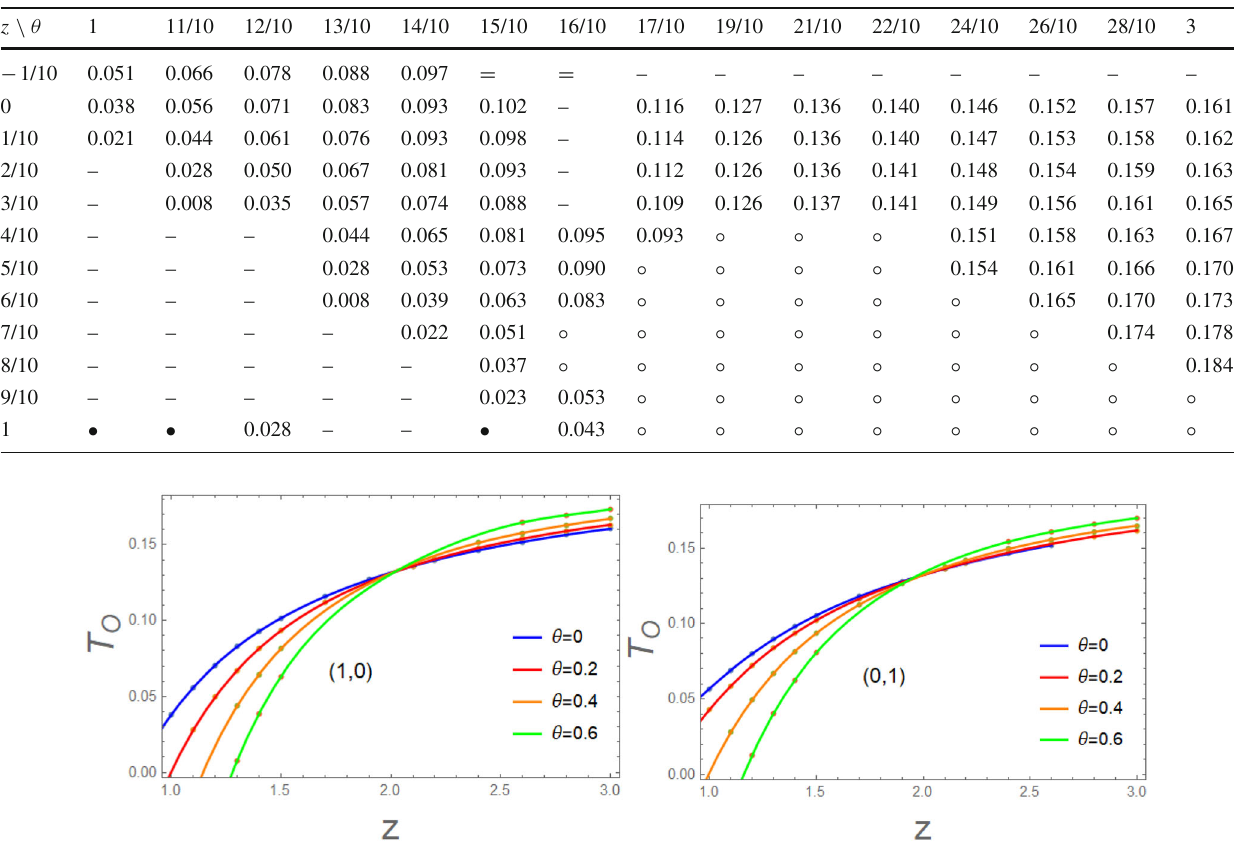
Fig. 7 Relationbetweentheoptimaltemperature T O and z ,θ .Themaximumcriticaltemperaturedefinestheoptimadoping.Left: ( q A , q B ) = ( 1 , 0 ) . Right: ( q A , q B ) = ( 0 , 1 )